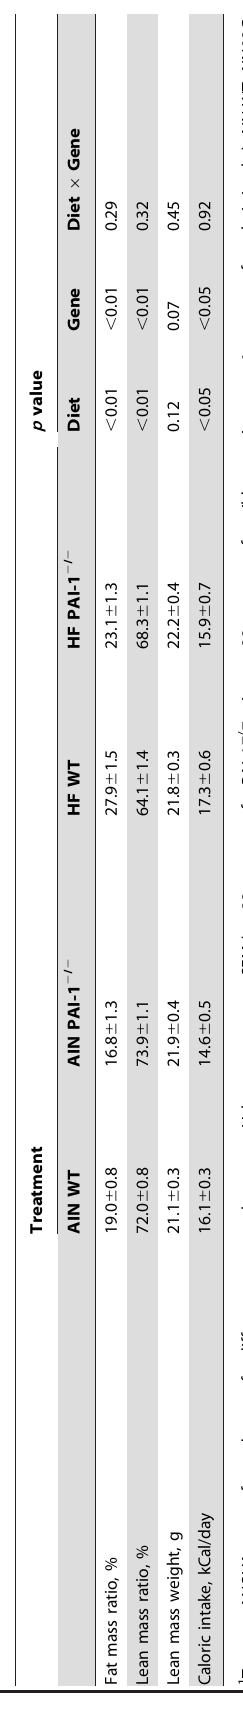
wild-type: p , 0.01) and a 5% increase in lean mass ( p , 0.01) (Table 2). Neither the high-fat diet nor PAI-1 deficiency affected absolute lean mass weight (Table 2). Consumption of the high-fat diet increased caloric intake by 8% (high-fat vs. AIN93G: p , 0.05) and PAI-1 deficiency lowered caloric intake by 9% (PAI-1 2 / 2 vs. wild-type: p , 0.05) compared to their respective controls (Ta- ble 2).